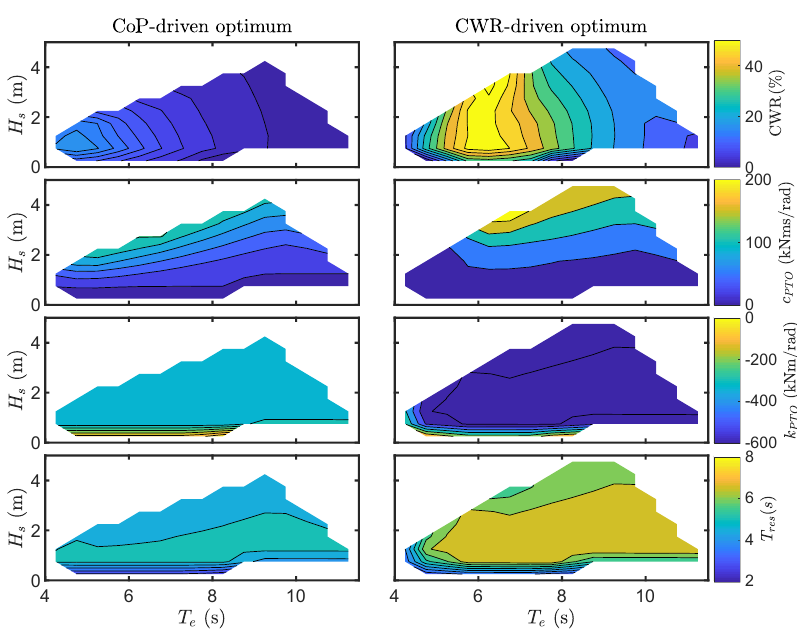
Figure 17. Capture width ratio, reactive control parameters and resonant period of the pendulum for the CoP-driven and CRW-driven optima. The same colour bar is used for each row, in order to favour